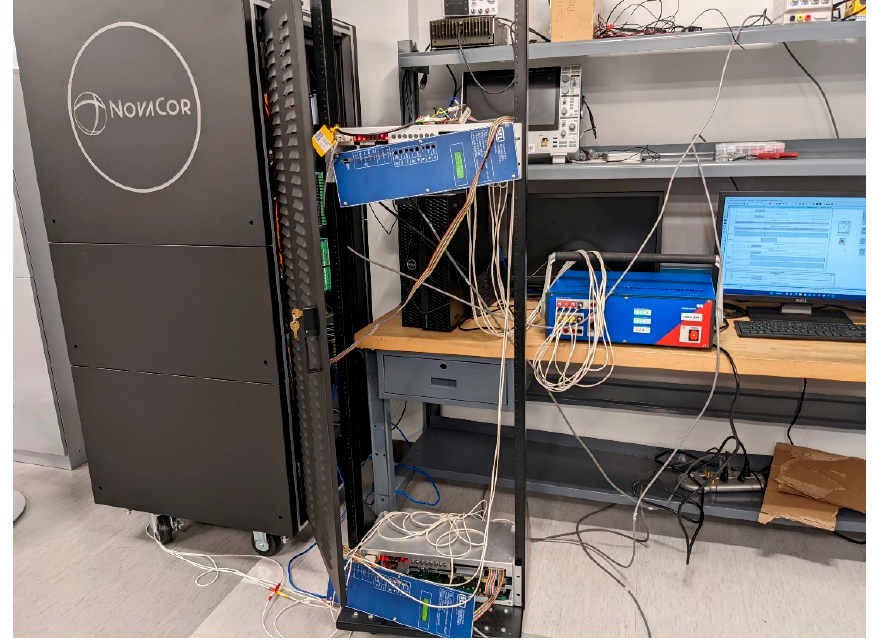
Figure 8. HIL setup for both SEL-351 relays, using RTDS .